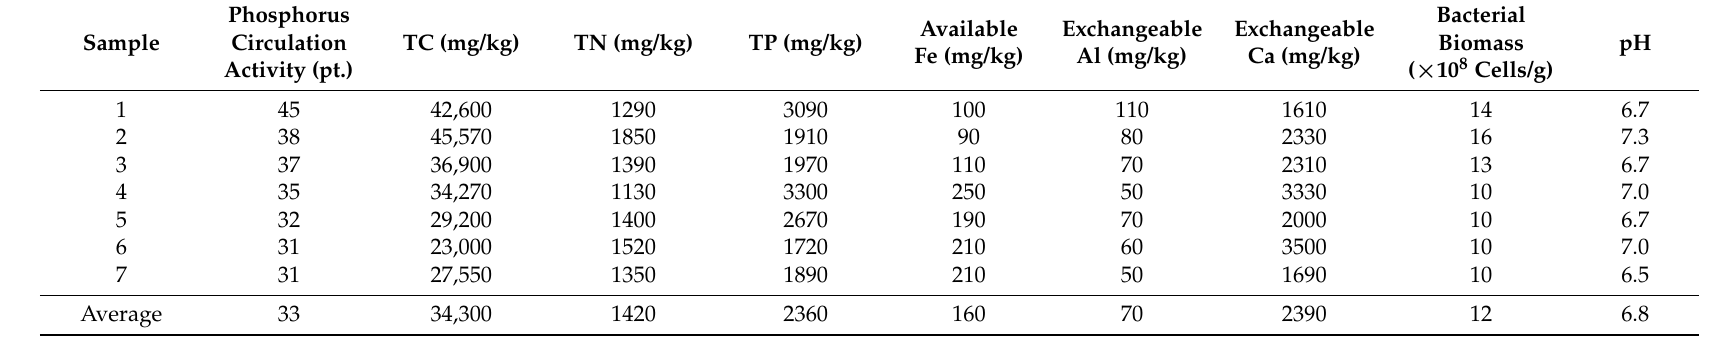
Table 2. Properties of soils showing higher phosphorus circulation activity (>30